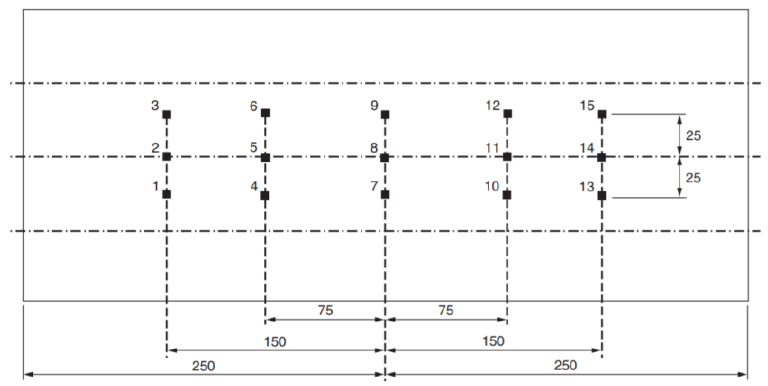
Figure 8. Measurement points location in mm (LC 21-410).